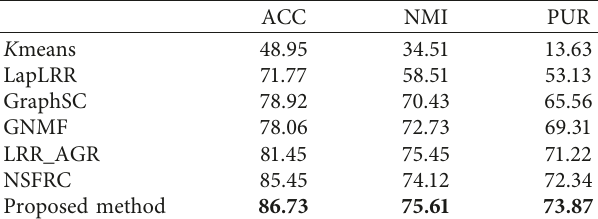
Table 4: Clustering results of different algorithms on ORL dataset. ACC